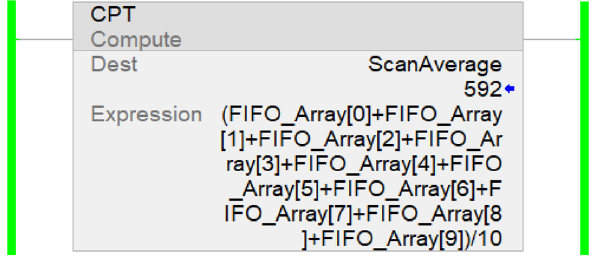
Fig. 17 Getting the average time of ten scan time values